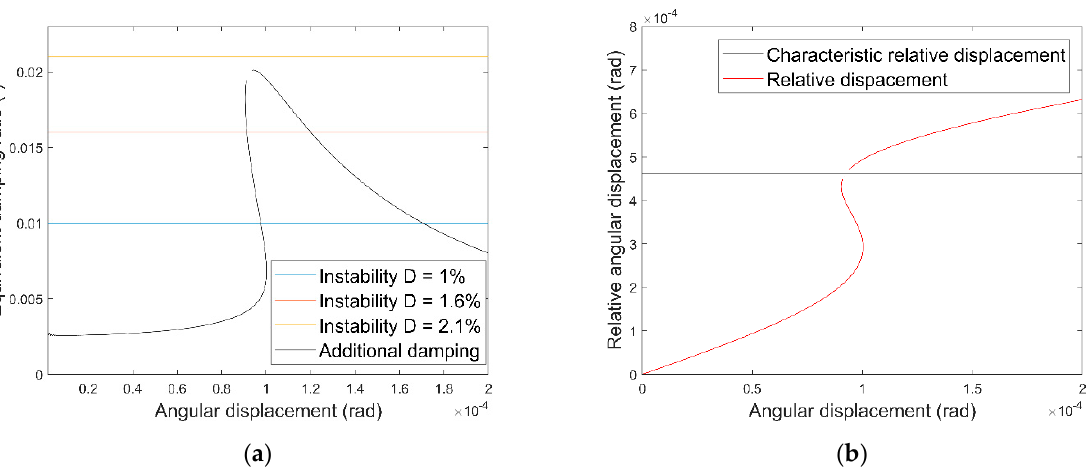
,(cid:2033) (cid:2868) = 1000 (cid:2869) , Ω = 1250 (cid:2869) , (cid:1836) = 0.2 (cid:1863)(cid:1859)(cid:1865) (cid:2870) ). ( a ) , ω 0 = 1000 1 , Ω = 1250 1 , J = 0.2 kgm 2 ). s s s (cid:3046) (cid:3046) (cid:3046)